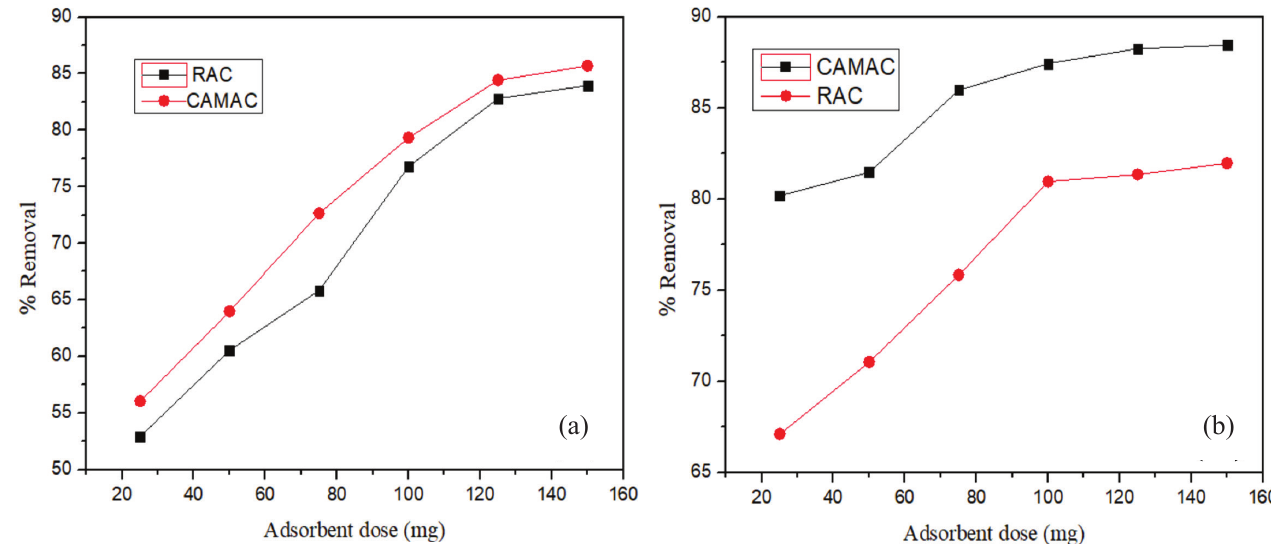
Fig. 7 – Effect of adsorbent dose for adsorption of Cu(II) (a) and As(III) (b) onto RAC and CAMAC